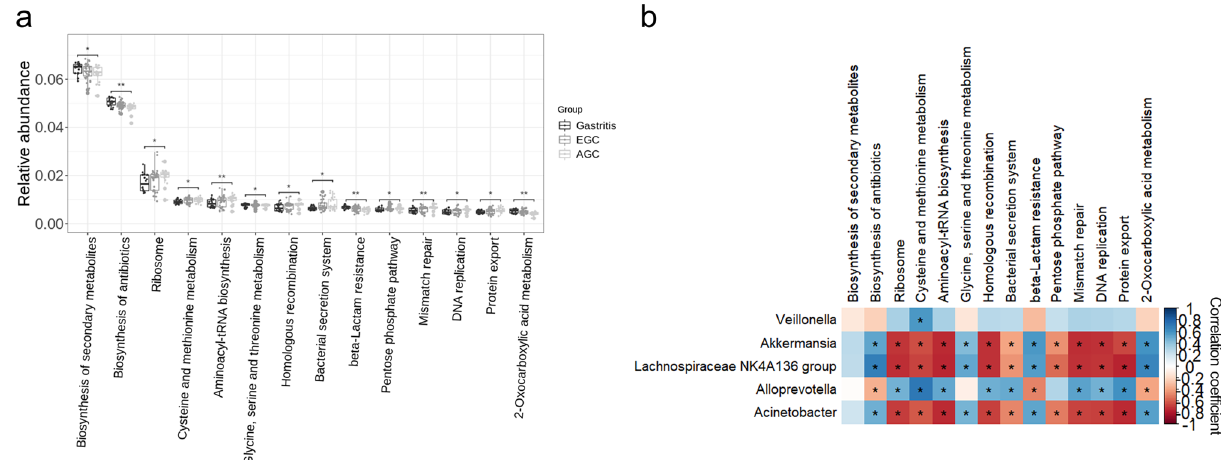
Figure 5. Predicted functional compositions of the gastric microbiome using Tax4fun based on KEGG. ( a ) Difference of predicted functional pathways between GA, EGC, and AGC groups. ( b ) Correlation between the predicted functional pathways and microbial biomarkers for gastric cancer are